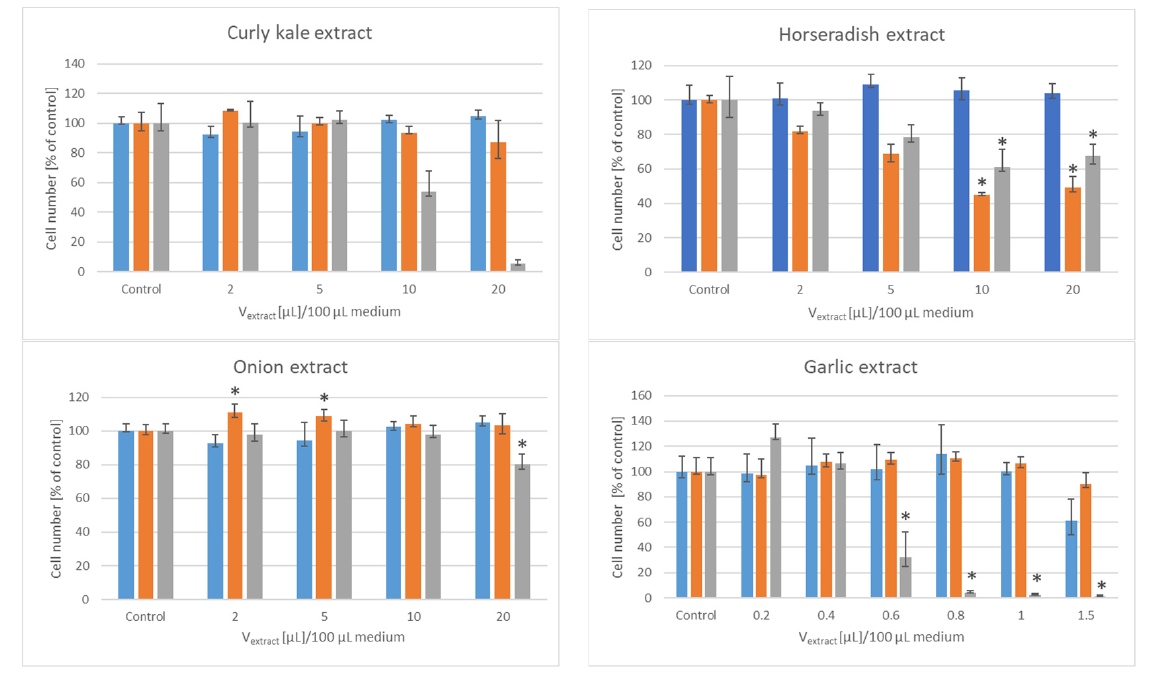
Figure 1. Effect of vegetable extracts on the proliferation of human ovary cancer cells and MRC-5 fibroblasts, estimated with Neutral Red; * p < 0.05.